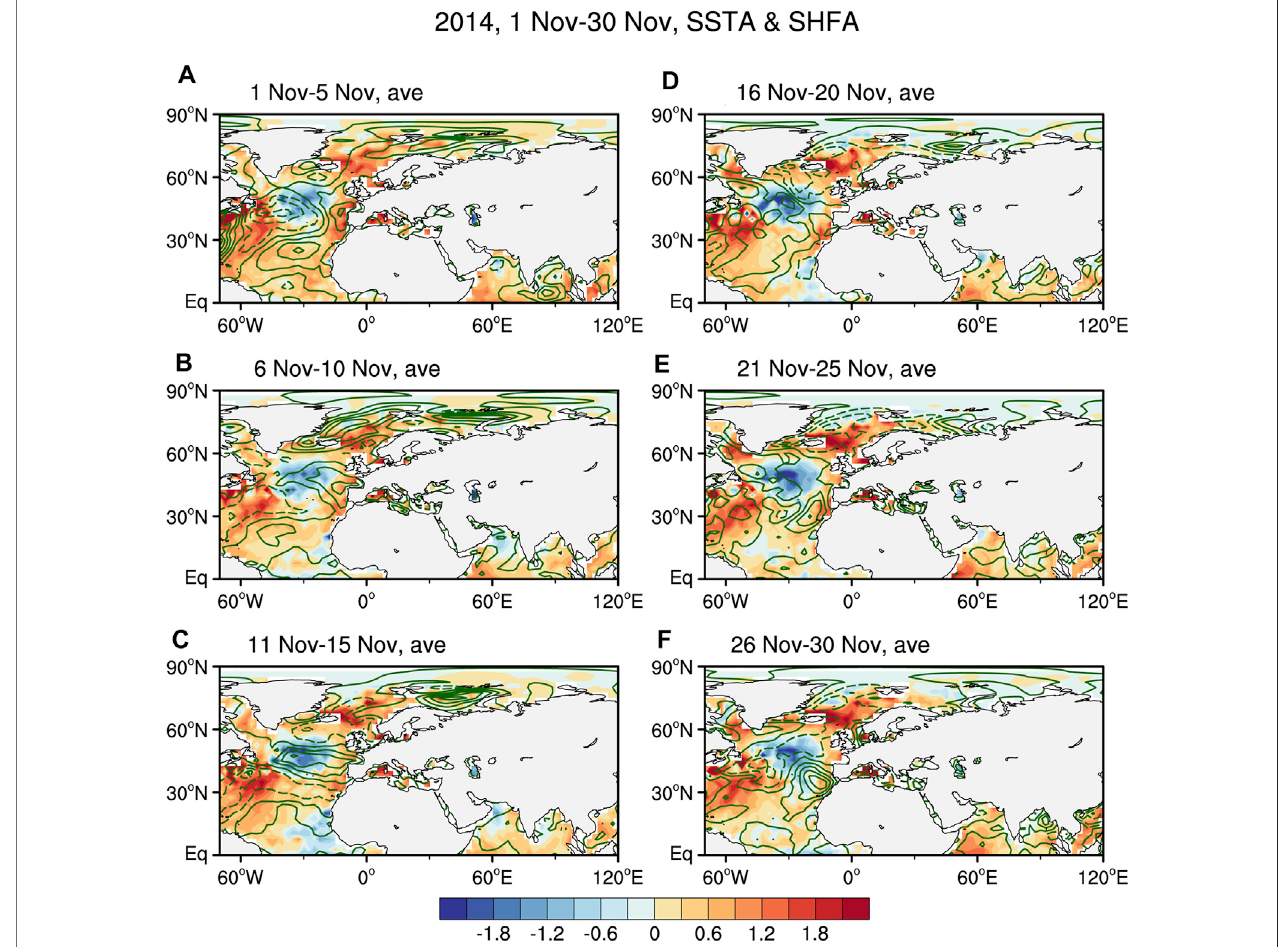
FIGURE 8 | Pentad-mean anomalies of SST (shading; unit: ° C) and surface heat fl ux (contours; positive values denote upward heat fl ux; unit: 10 W m − 2 ) in November 2014.